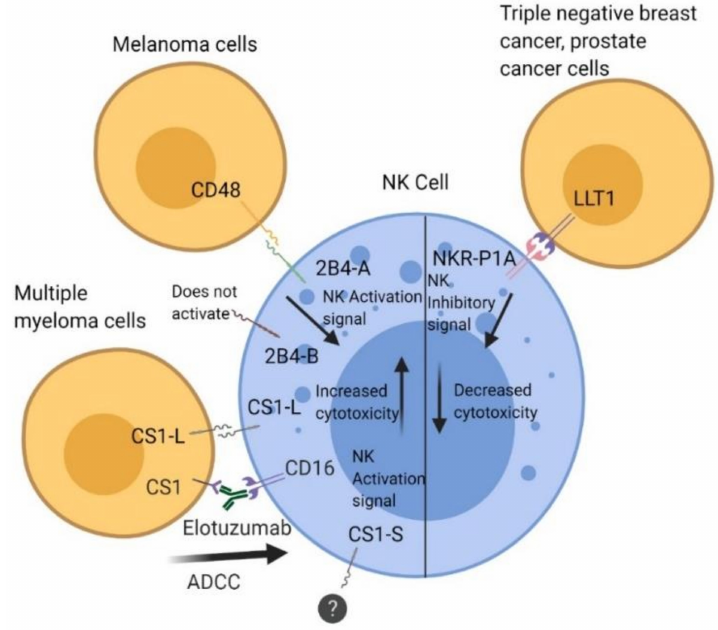
Figure 1. Interaction of 2B4, CS1, and lectin-like transcript 1 (LLT1) with their ligands in regulation of natural killer (NK) cell function. The 2B4 receptor is a heterophilic receptor that interacts with CD48 (SLAMF2) and has an activating function that increases cytolytic function in NK cells. CS1 is a homophilic receptor and comes in two isoforms: CS1-L and CS1-S. CS1-L has an activating role that improves cytolytic function, whereas CS1-S has no known function, but both are expressed constitutively on NK cells. Antibody-dependent cell-mediated cytotoxicity (ADCC) occurs through binding of the Fc portion of Elotuzumab to CD16 receptors on NK cells. LLT1 is a heterophilic receptor that interacts with NKR-P1A on NK cells. Interaction of LLT1 on triple-negative breast cancer (TNBC) and prostate cancer cells with NKRP1A on NK cells inhibits cytolytic